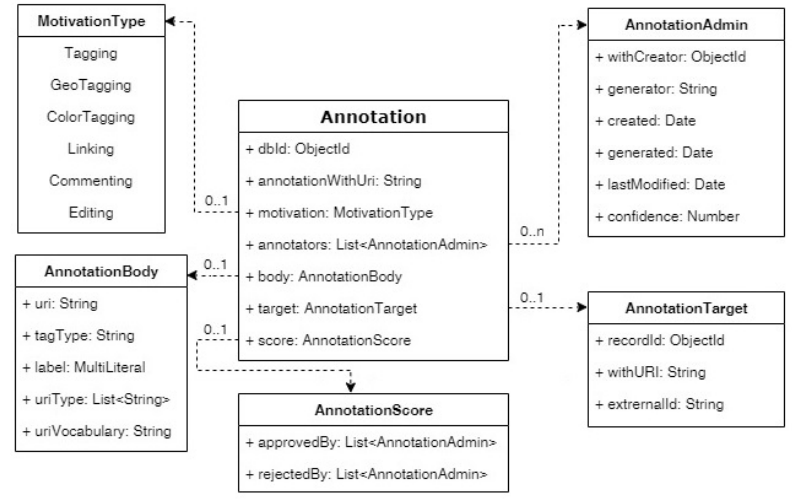
Figure 5. Annotation class